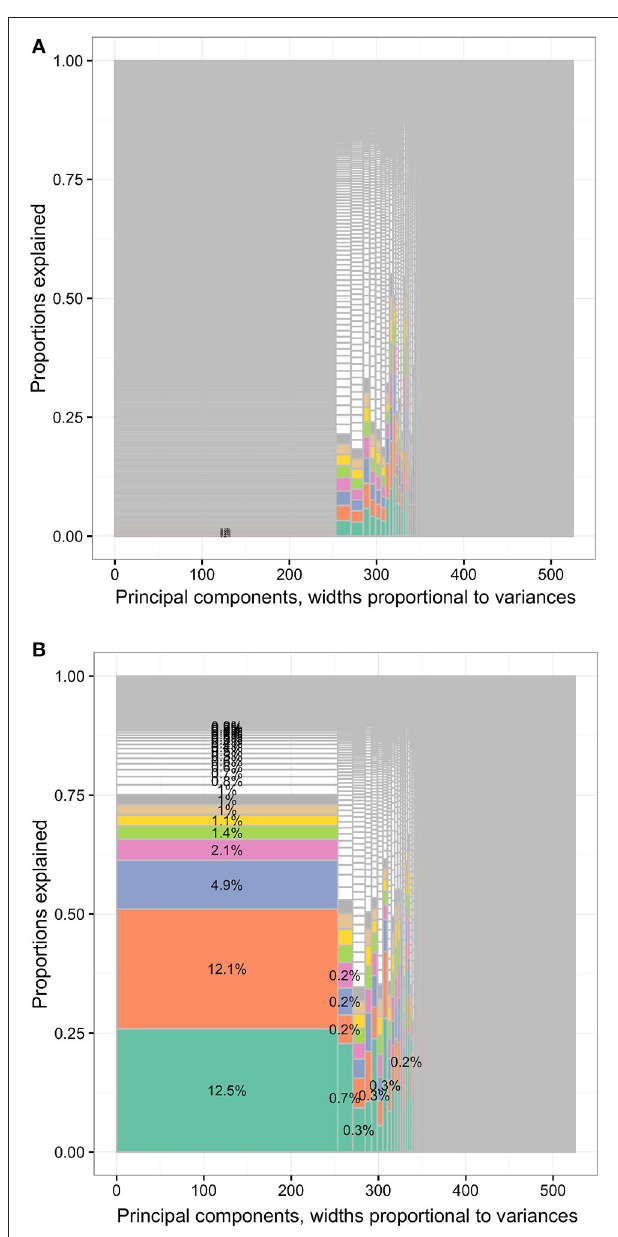
FIGURE 9 | The distribution of total variances by principal components and input variables or approximation variables in the MEPS 1996–2011 panels. Principal components, widths proportional to variances. (A) The distribution of total variances by principal components and input variables. Principal components, widths proportional to variances. (B) The distribution of total variances by principal components and approximation variables. MEPS, Medical Expenditure Panel Survey. The percentages in the cells representing the percentages of variances relative to total variance (whole area) based on the loadings of principal component analysis (first charts) or R squared. Each column represented the principal components (PCs) and had widths the same as the PC variance. In each column, the cells were of unequal sizes representing the variances explained by the input variables. For each PC specified in each column, the PC was explained by input variables. The cells in each column represented the input variables. The cell sizes were proportional